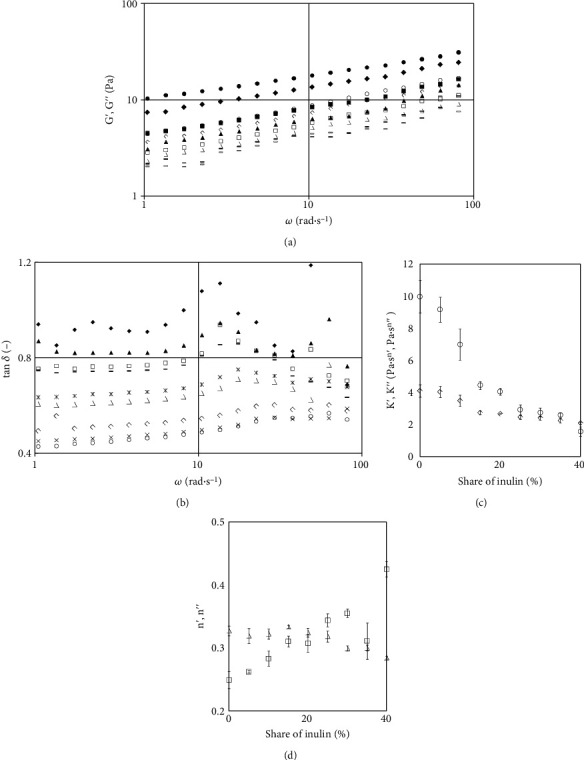
Mechanical spectra, tangent of the phase shift angle, and dependency of power-law model parameters on inulin contribution: (a) mechanical spectra (G′ filled symbols, G″ empty symbols): ◯, • 0%; ◊, ♦ 10%; □, ▪, 20%; ∆, ▲ 30%; and − , □ 40%. (b) Tangent of the phase shift angle: ◯ 0%, × 5%, ◊ 10%, ∆ 15%, ∗ 20% □ 25%, − 30%, ▲ 35%, and ♦ 40%. (c) Dependency of K′ and K″ on inulin contribution: K′, ◊ K″. (d) Dependency of n′ and n″ on inulin contribution: □ n′, ∆ n″.